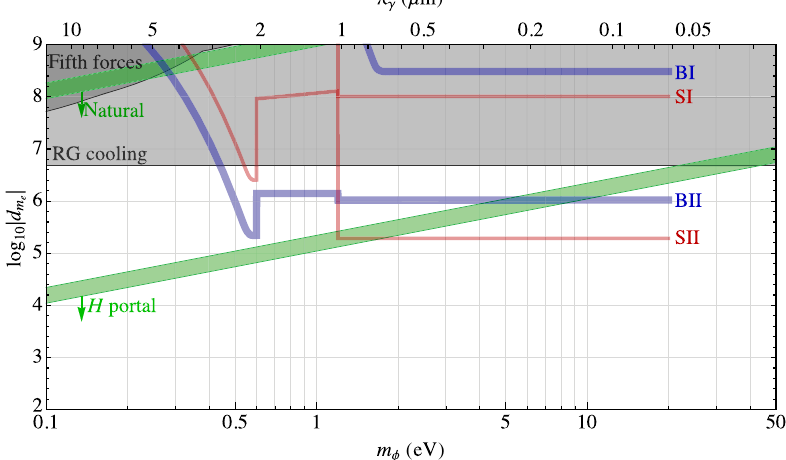
FIG. 10. Reach for the scalar dark matter coupling d to electrons as a function of scalar mass m ϕ . Sensitivity projections for the bulk m e (BI, BII) and stack (SI, SII) configurations are shown with assumptions as listed in Table IV. Gray exclusion regions depict constraints from stellar cooling processes in red giants (RG) and from short-range fifth-force searches. Parameter space below the upper green band is technically natural (i.e., not fine-tuned) for a 10-TeV cutoff, while the H portal model [see Eqs. (134) and (135)] populates the region below the lower green